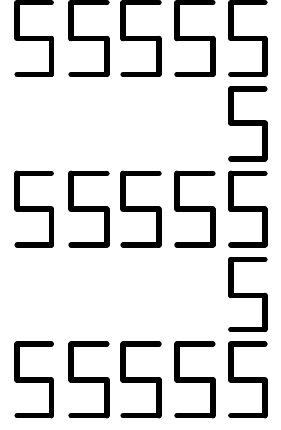
Fig. 1. Example of large-digit made up